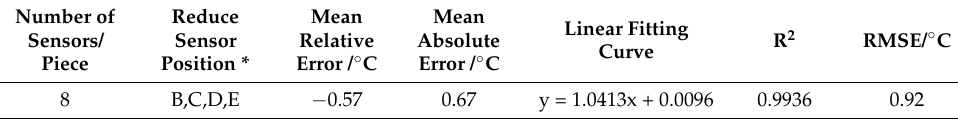
Table 8. Linear correlation analysis results after reducing 16